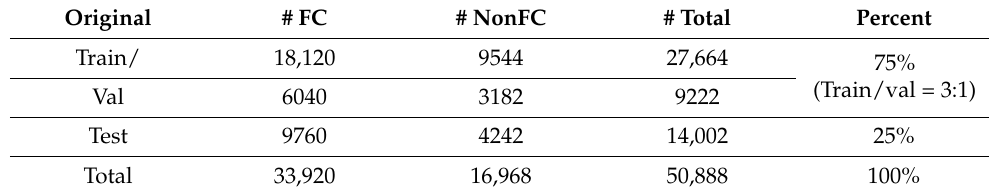
Table 2. The number of FC/NonFC for training/validation and test processing.